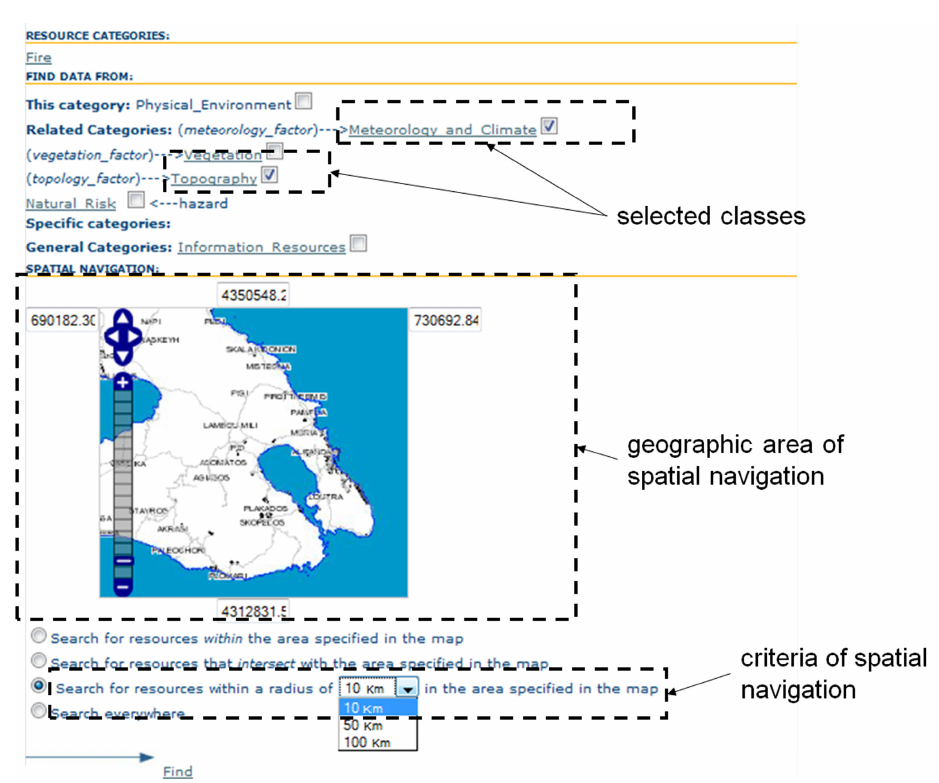
Fig. 10. Specifying the criteria of spatial navigation in